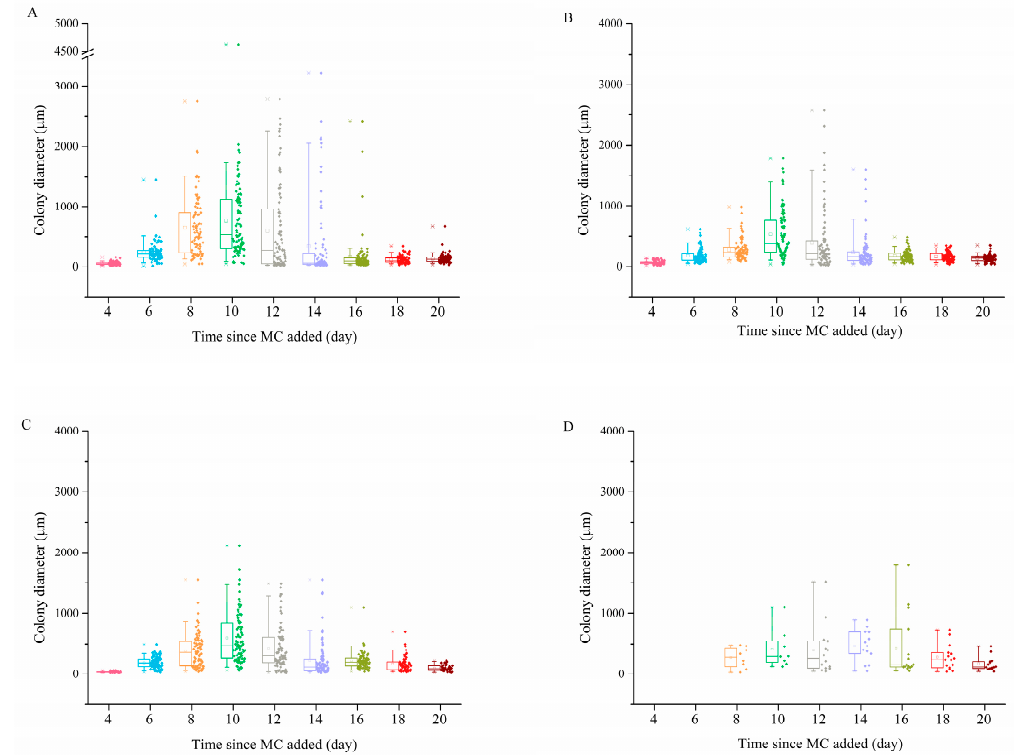
Figure 5. Changes in P. globosa colony diameter in the ( A ) control group, ( B ) 0.1 g/L MC-treated group, ( C ) 0.2 g/L MC-treated group and ( D ) 0.5 g/L MC-treated group. The error bars of the 5% and 95% are shown together below and above the box. Square dots in the box represent the mean values and the middle lines represent the